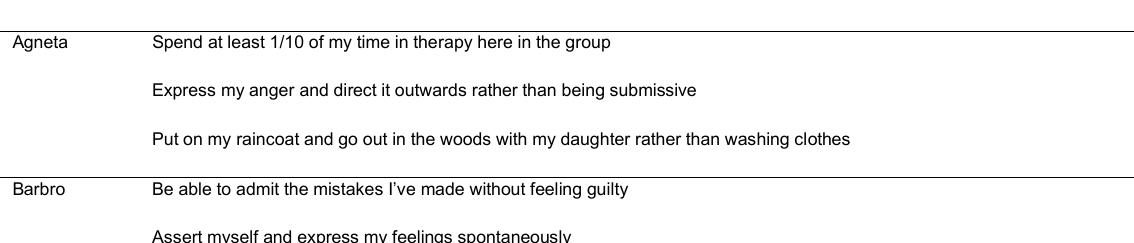
Table 4: The treatment contracts of the 5 clients who participated in transactional analysis group therapy.